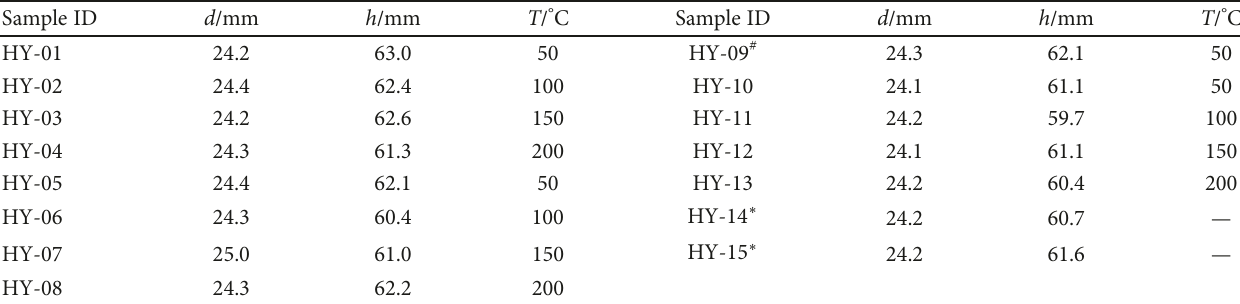
Table 2: Basic parameters and processing temperature of coal samples.